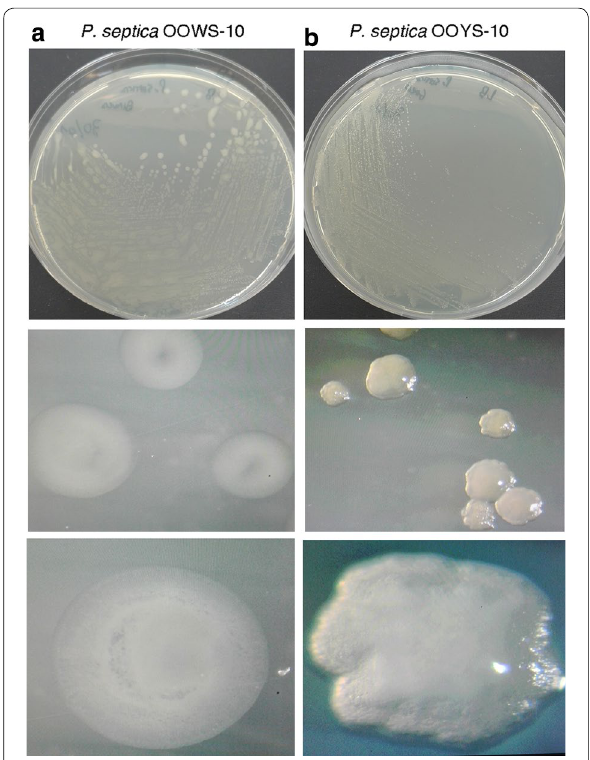
Fig. 3 NJ phylogenetic tree based on 16S rRNA gene sequences showing the position of Sporobolomyces roseus OOPS-1, OOPS-10 and their strictly related reference strains. Bootstrap values (expressed as percentages of 1000 replicates) of filled square, indicate that the corresponding nodes were also recovered in trees constructed using MP, ML, and both algorithms, respectively. Bulleromyces albus MUCL 30301 T was used as an outgroup. Bar, 0.1 substitutions per nucleotide position